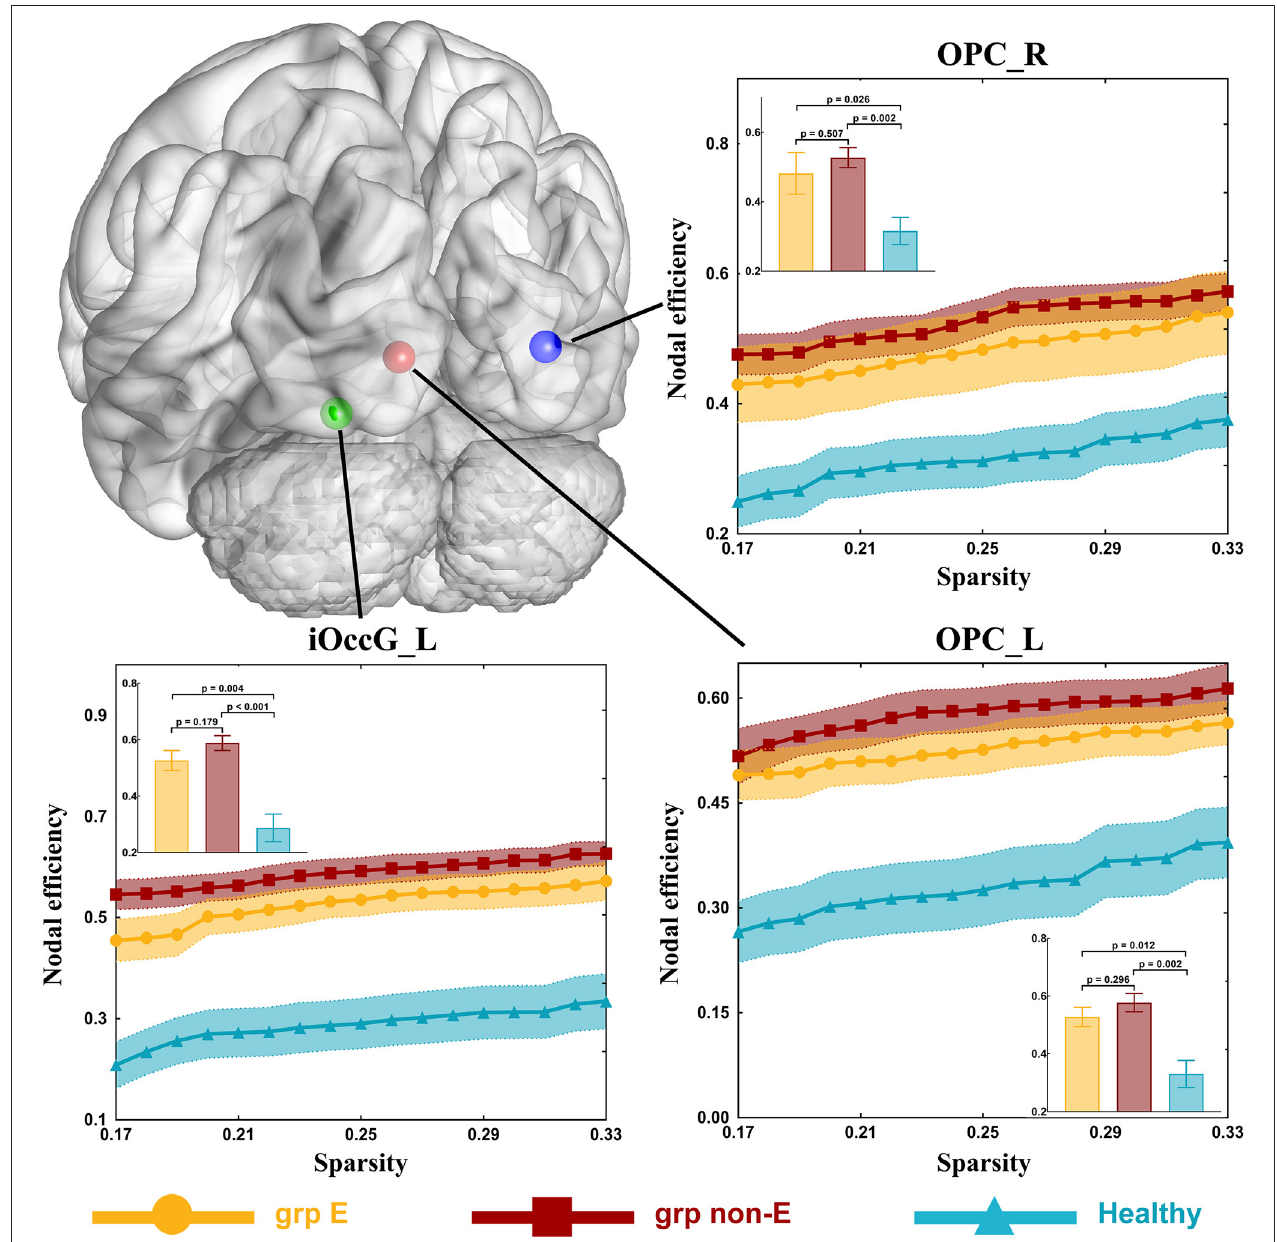
FIGURE 3 | Significant alterations in nodal efficiency. Grp E = GRE group. P -value threshold after FDR correction is 0.002. Grp non-E = non-GRE